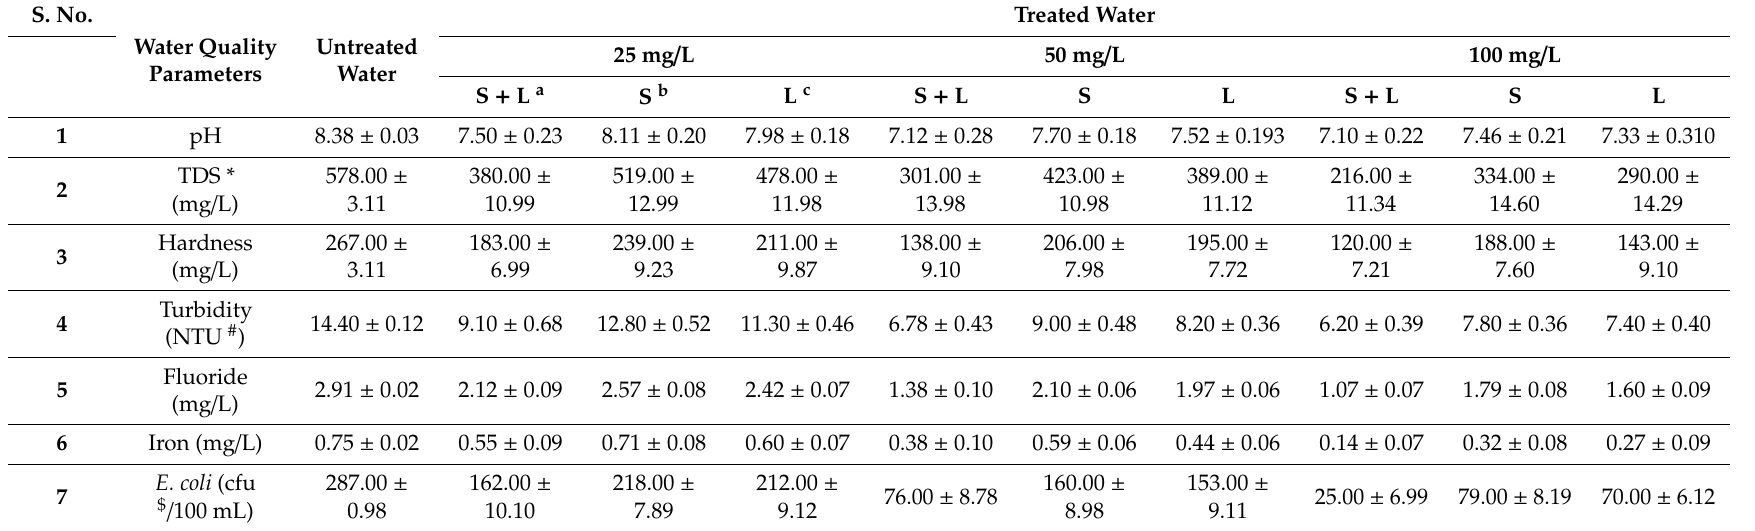
Table 1. Comparison of the e ff ects of di ff erent plant parts of Moringa oleifera (seeds and leaves) on groundwater. S.